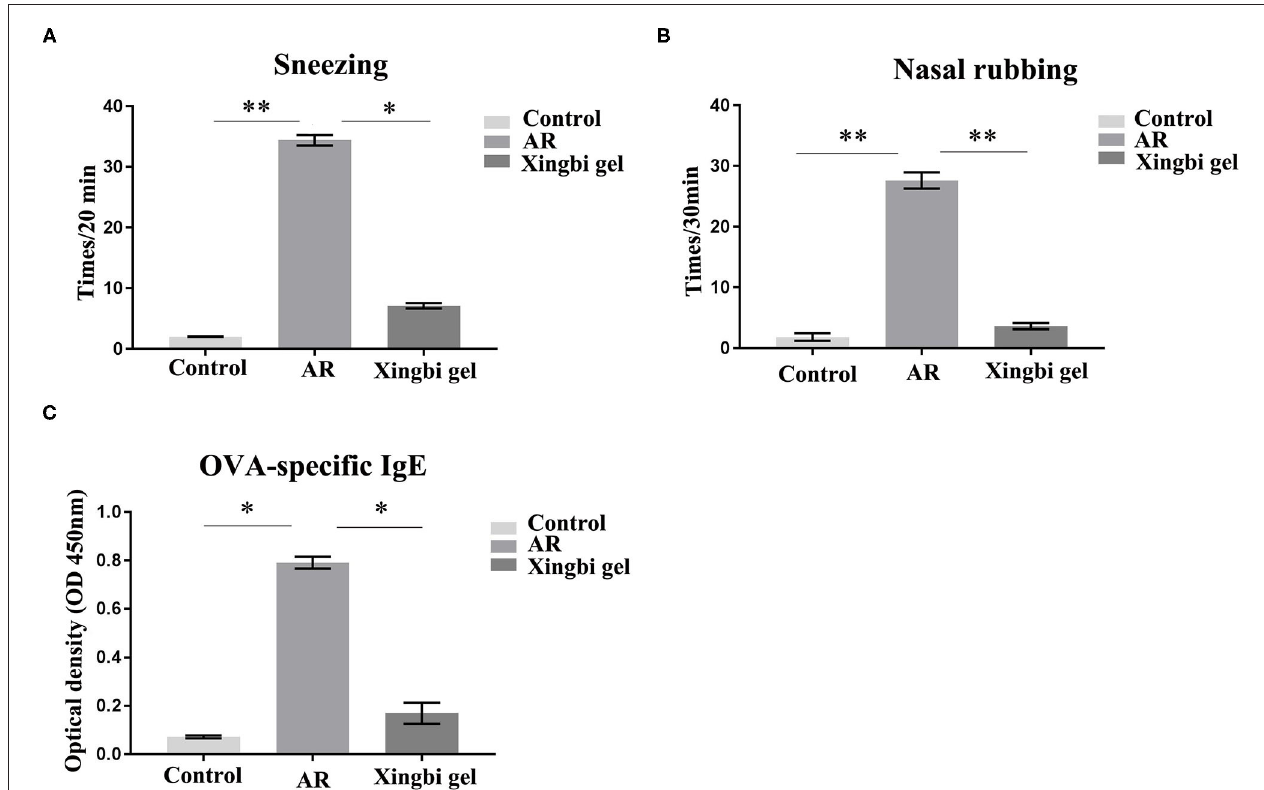
FIGURE 1 | The frequency of sneezing and scratching and IgE content in AR mice increased. (A) Compared with the control group, the number of sneezes in AR group increased significantly, and the number of sneezes decreased after treatment with Xingbi gel; (B) Compared with the control group, the number of nasal scratching in AR group increased significantly, and the number of nasal scratching decreased significantly after treatment with Xingbi gel. (C) ELISA was used to detect IgE levels in the blood of all mice. Compared with the control group, IgE levels in the AR group were significantly increased, while IgE levels in the Xingbi gel group were decreased. ** P < 0.01; * P <